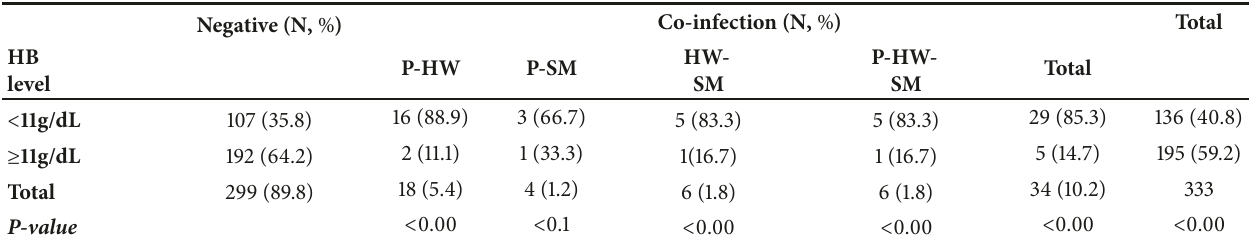
Table 4: The prevalence of anaemia among coinfected children in Northwest Ethiopia, 2016.